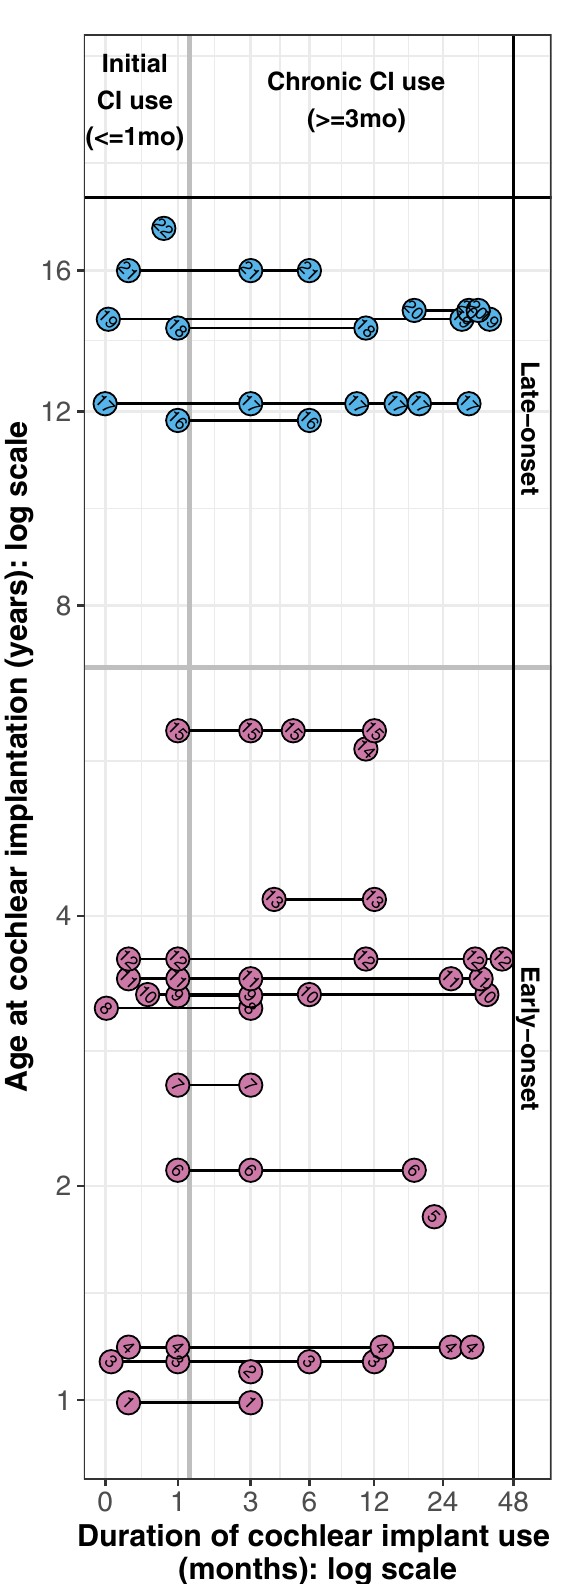
Figure 6. Timing of EEG recording in each child. Children in both the early (pink) and late (blue) onset SSD groups completed multiple EEG recording sessions, spanning from initial CI use (0–1 month) to chronic CI use (≥ 3 month). Study codes (details in Table 1) are